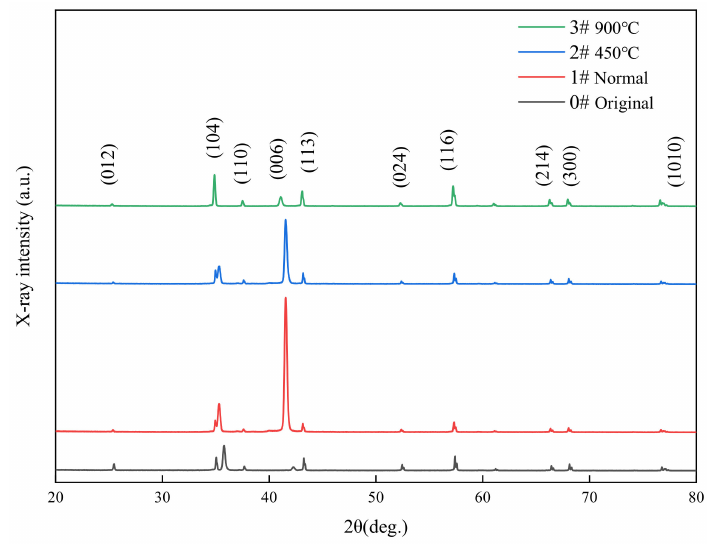
Figure 13. XRD spectra of laser-polished alumina ceramics before and after